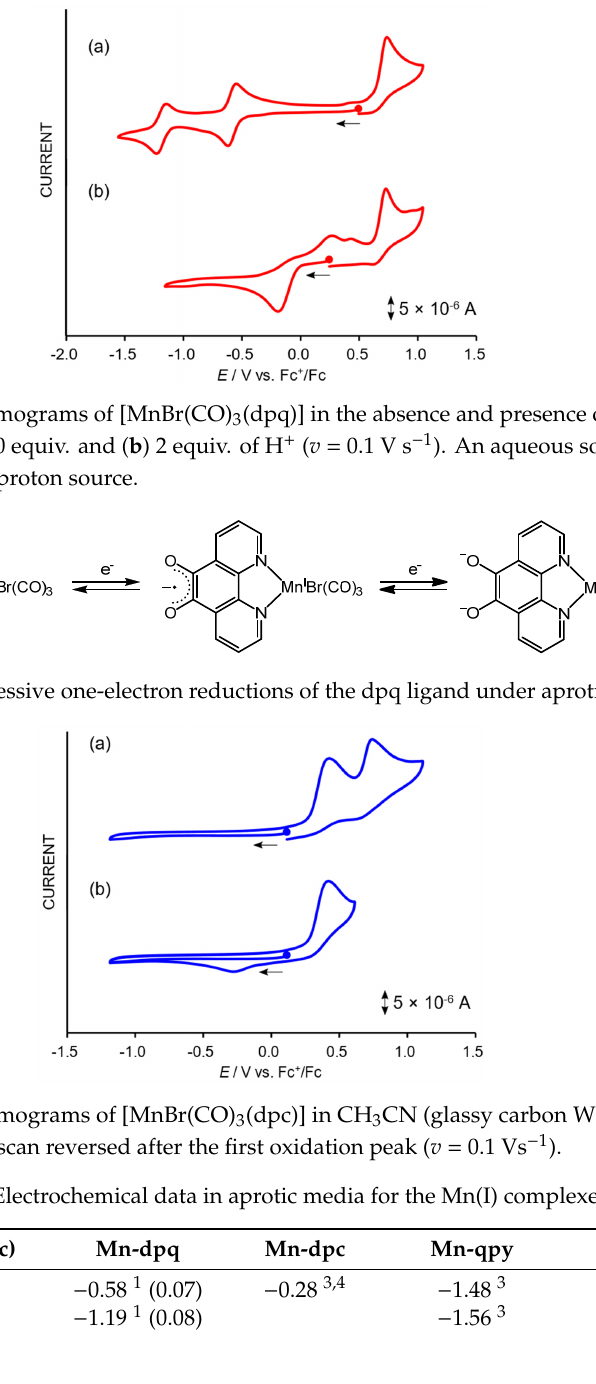
Reaction (V vs. Fc + /